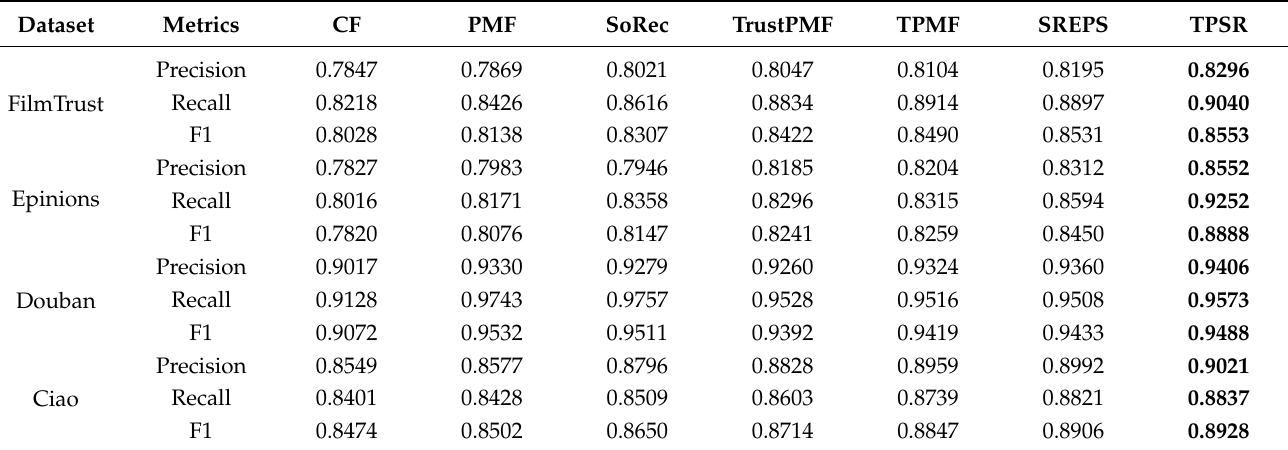
Table 5. Item Recommendation List Quality